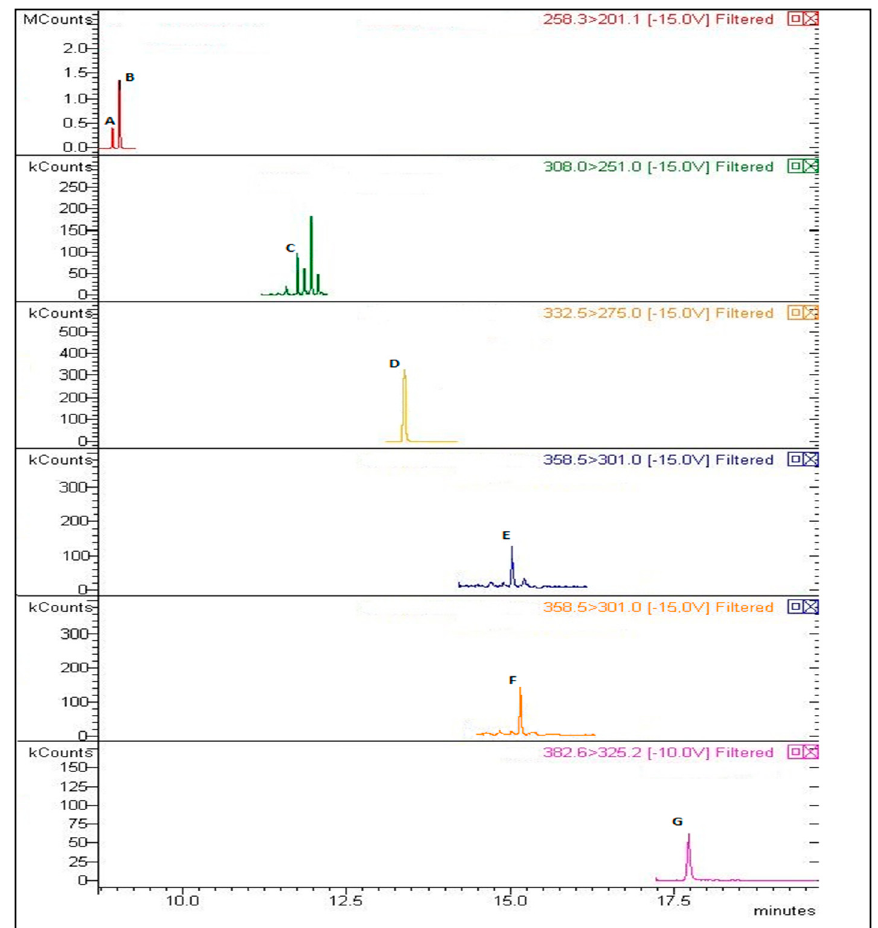
Figure 4. Chromatogram of OH-PAHs by gas chromatography (GC)/triple quadrupole-mass spectrometry (QpQ-MS) in spiked artificial urine. A = 1-OH-Nap (200 ng/L); B = 2-OH-Nap (600 ng/L); C = 9-OH-Phen (50 ng/L); D = 1-OH-P (400 ng/L); E = 3-OH-B[a]A (1 ng/L); F = 9-OH-B[a]A (1 ng/L); G = 3-OH-B[p]A (5 ng/L).